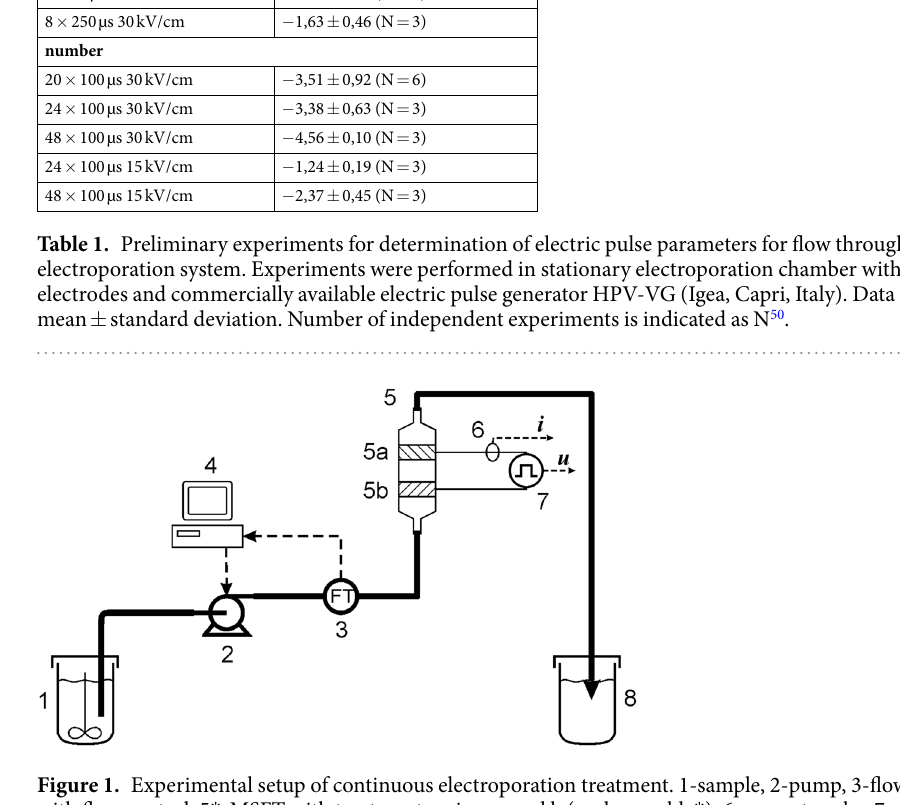
Figure 1. Experimental setup of continuous electroporation treatment. 1-sample, 2-pump, 3-flow sensor, 4-PC with flow control, 5 * -MSFT with treatment regions a and b (exchangeable * ), 6-current probe, 7-voltage probe, 8-treated sample of E. coli for plating on Petri dishes. * When linear chamber was used it replaced MSFT in position 5. The linear chamber is described in details in refs 47 and 48. Schematic drawing of chambers is given in Fig.